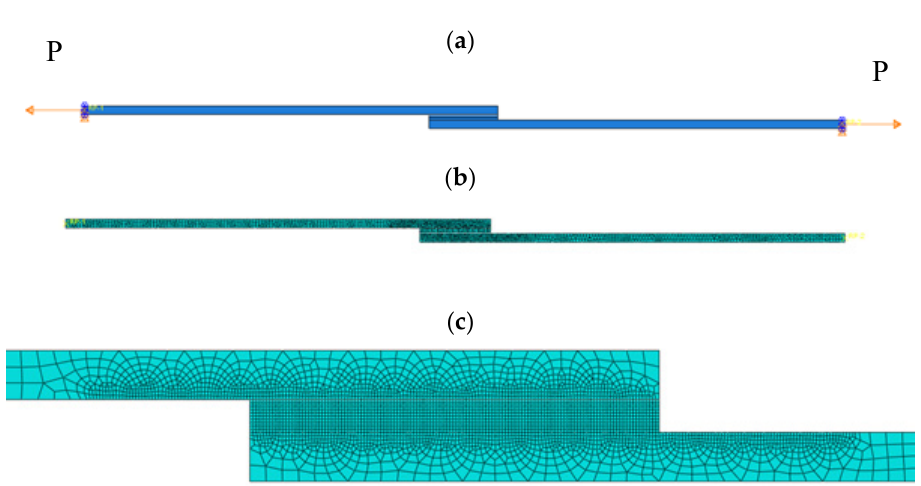
Figure 13. A specimen for numerical calculations: ( a ) manner of loading, ( b ) distribution of a finite element grid, ( c ) form of a grid of finite elements within the adhesive joint.